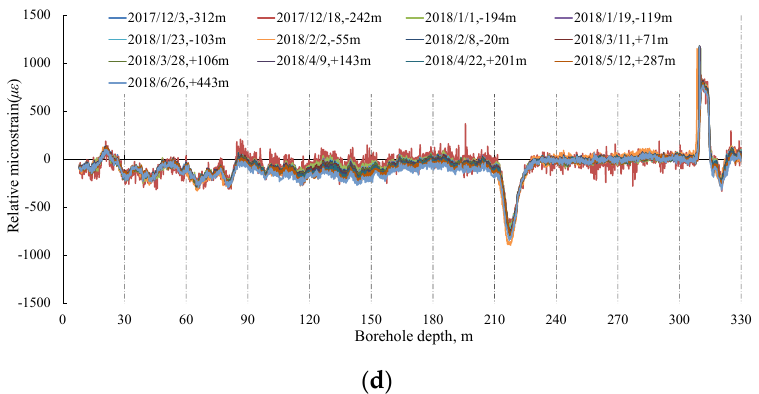
Figure 16. Distributed optical fiber monitoring data in the Y2 borehole: ( a ) metal-based optical fiber; ( b ) 130m, Y2-3#; ( c ) 260 m, Y2-2#; and ( d ) 330 m, Y2-1#.